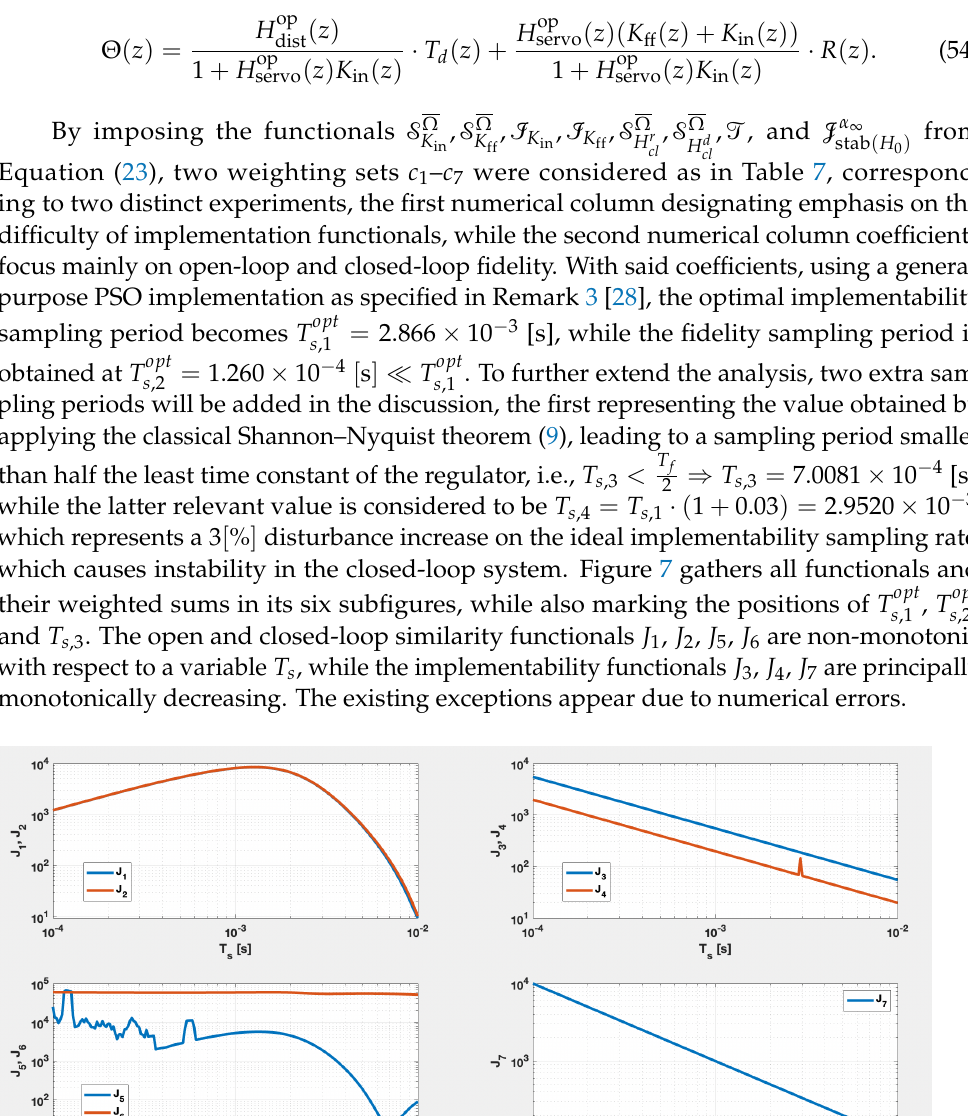
, (cid:83) Ω , (cid:73) K , (cid:73) K , (cid:83) Ω , (cid:83) Ω , (cid:84) , (cid:74) α ∞ , respectively, K in K ff H r cl stab ( H 0 ) H d cl in ff